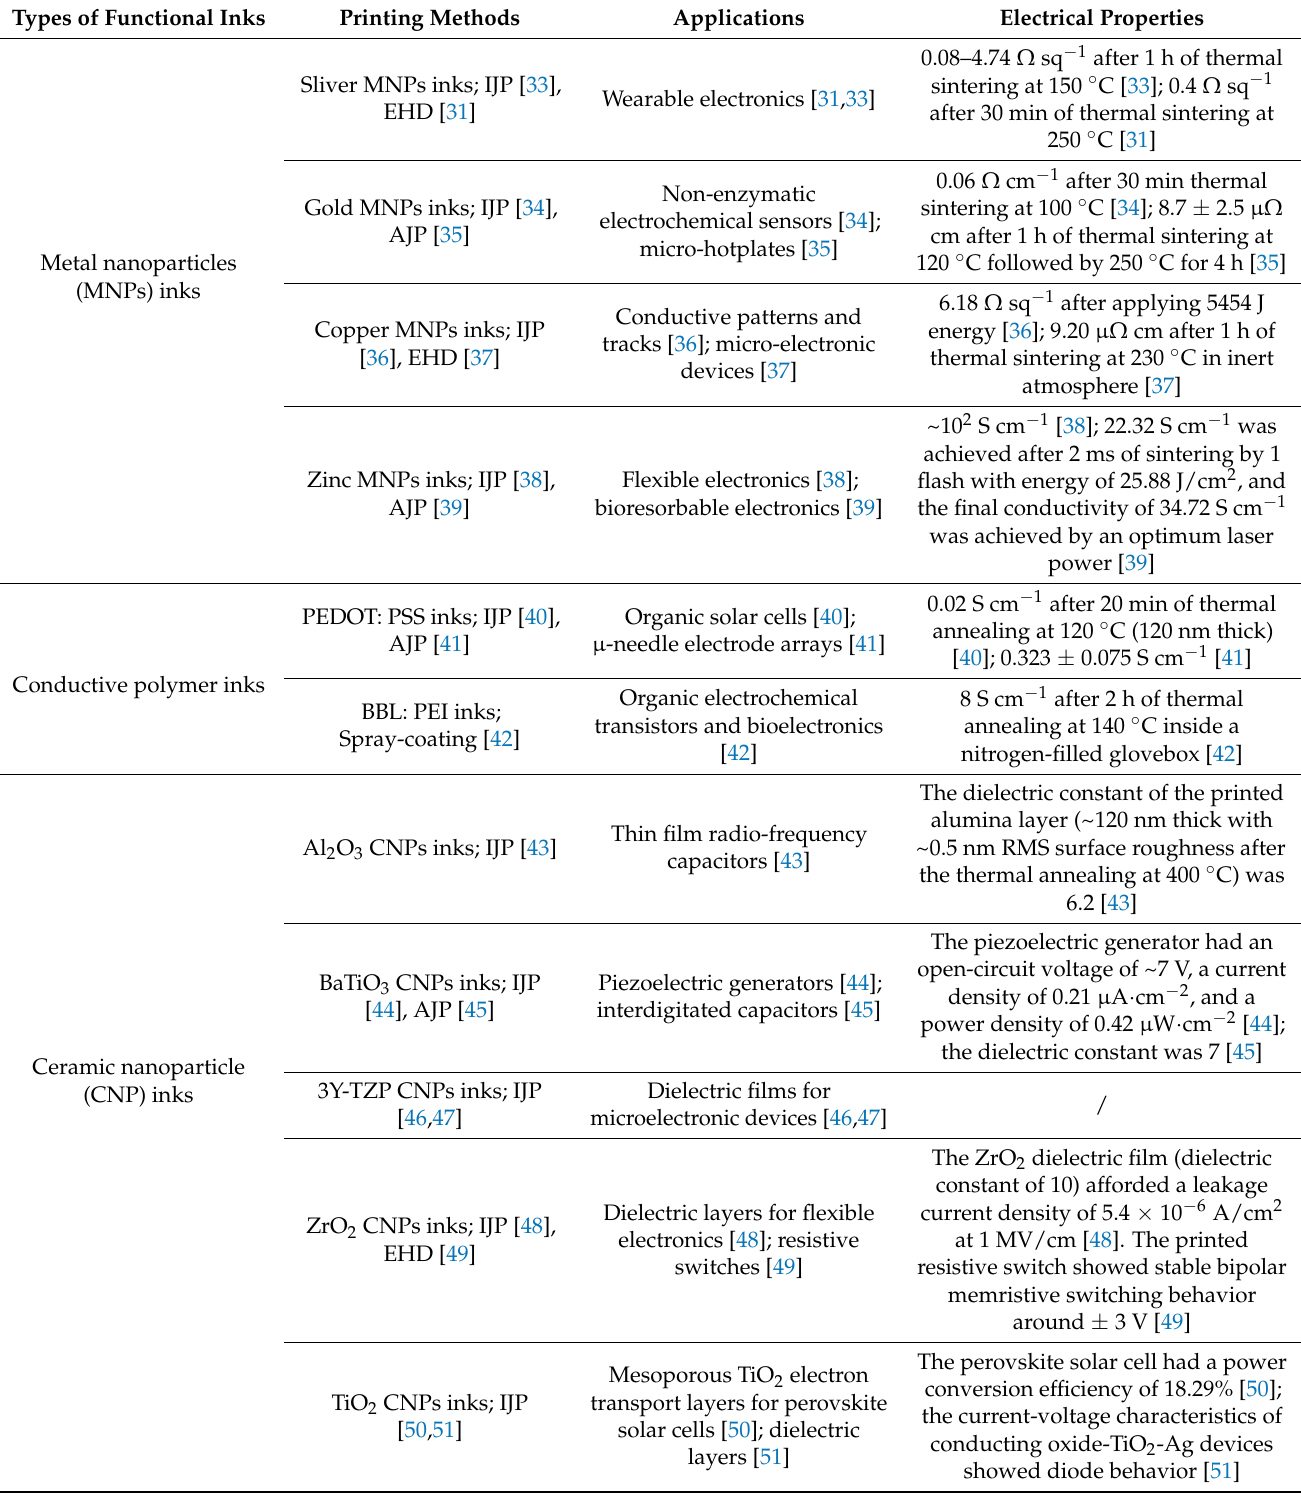
Table 1. Summary of recently developed functional